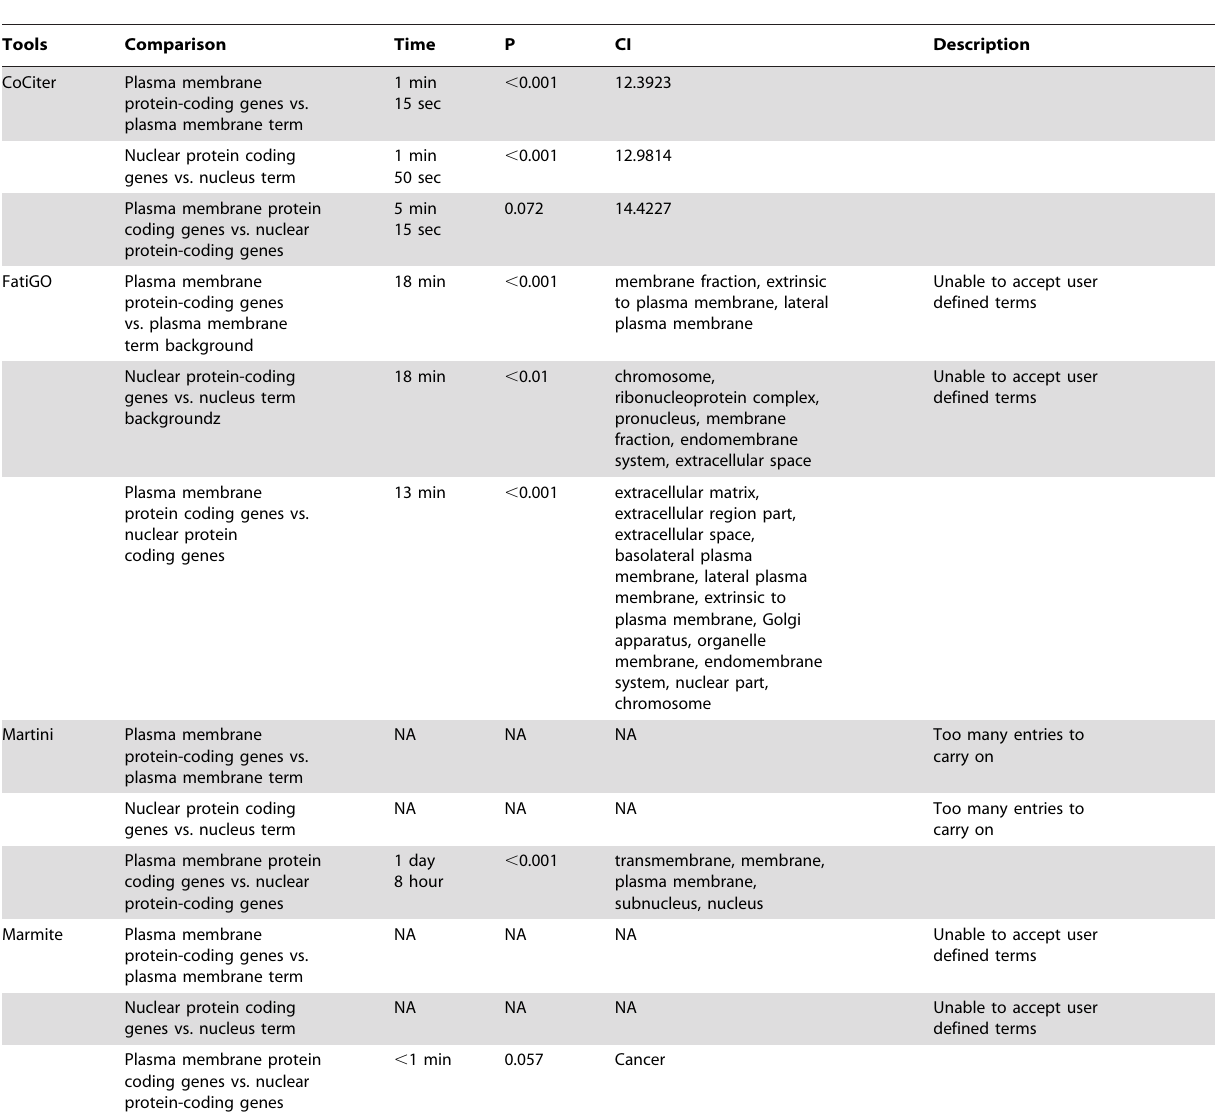
Table 3 . Performances of CoCiter, FatiGO, Martini and Marmite on the nuclear and plasma membrane protein-coding dataset.